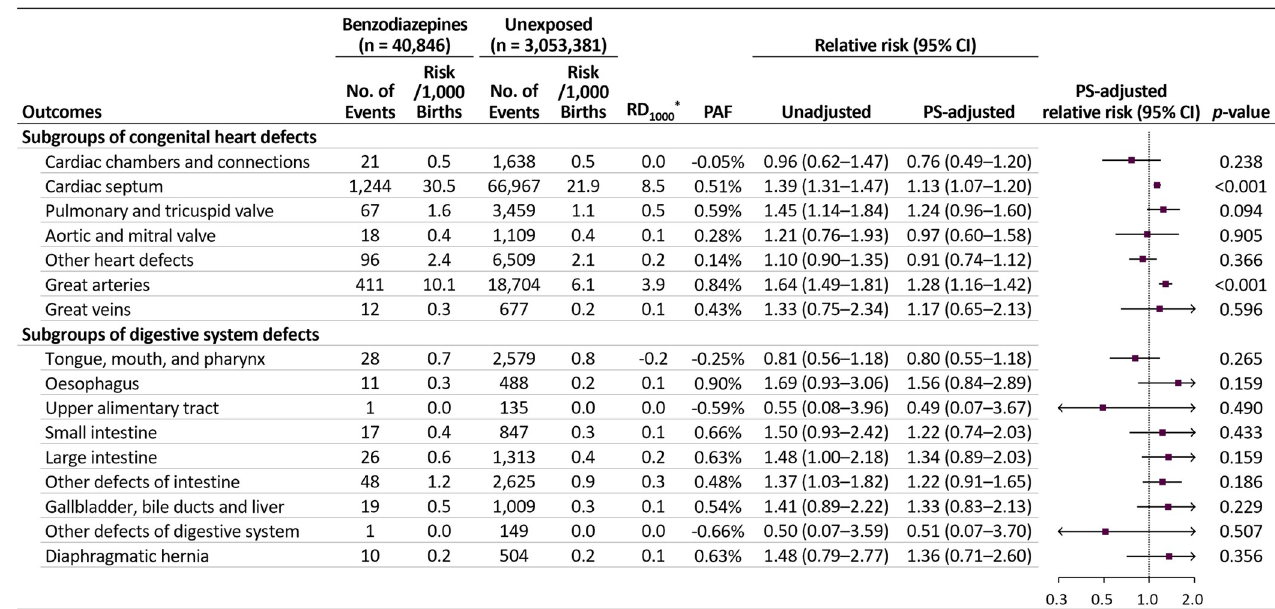
Fig 2. Risks of individual categories of heart and digestive system defects in infants following maternal exposure to benzodiazepines during the first trimester. CI, confidence interval; PAF, population attributable fraction; PS, propensity score; � RD 1000 , risk difference per 1,000 births.